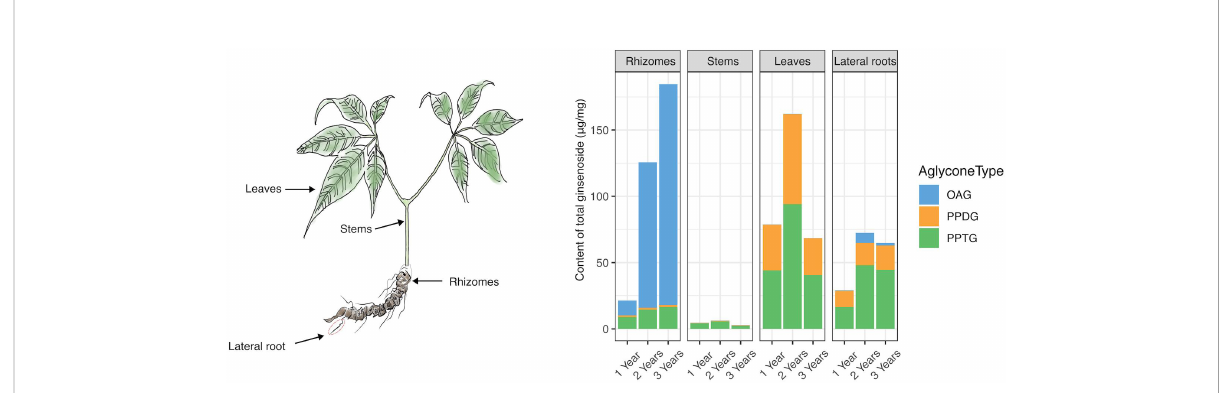
FIGURE 2 The cumulative histogram plotting for the total content of ginsenosides measured in different P. japonicus samples. Eighteen investigated ginsenosides in four plant tissues from P. japonicus over the early growth stage. Data represent the mean of three biological replicates. “ OAG ” represents OA-type ginsenosides, containing 6 ginsenosides. “ PPDG ” is PPD-type ginsenosides, containing 8 ginsenosides. “ PPTG ” represents PPT-type ginsenosides, containing 4 ginsenosides.